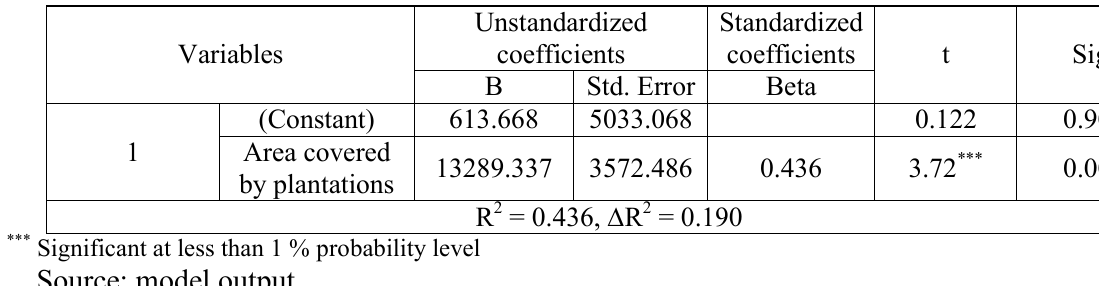
Table 2. Simple regression estimates of annual households income (n =